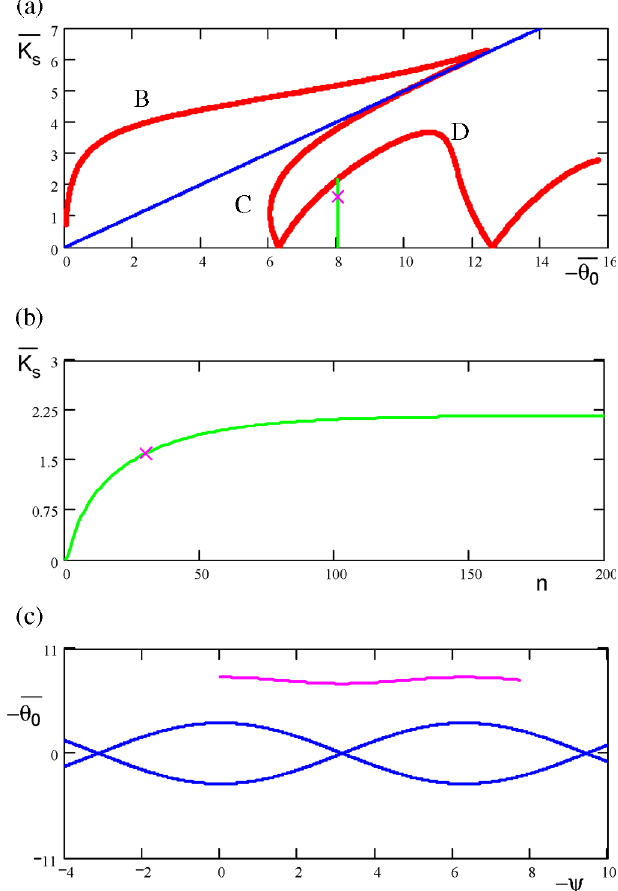
VIDEO 2. Dynamics of the oscillation buildup in the